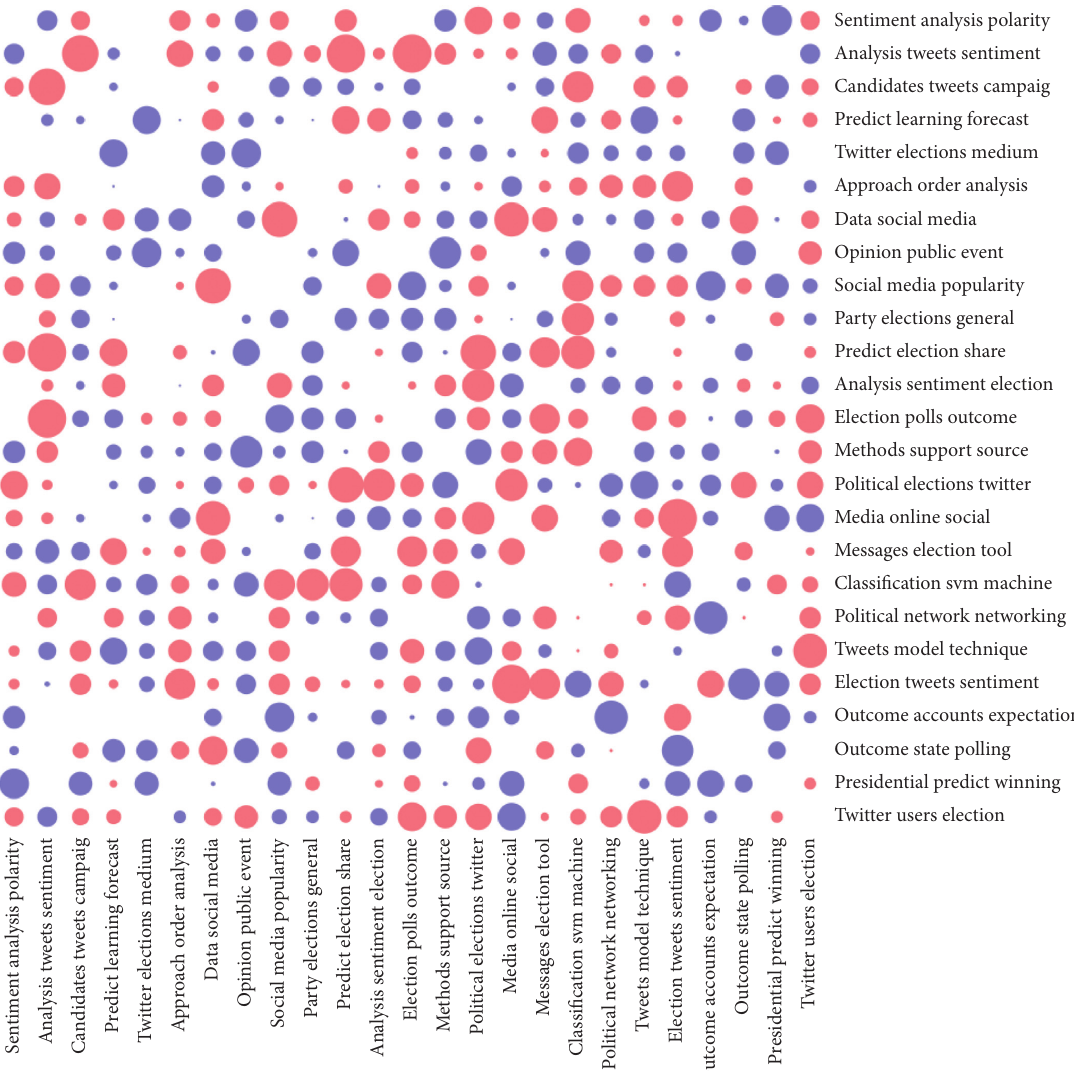
Figure 13: Topic correlation of the selected studies’